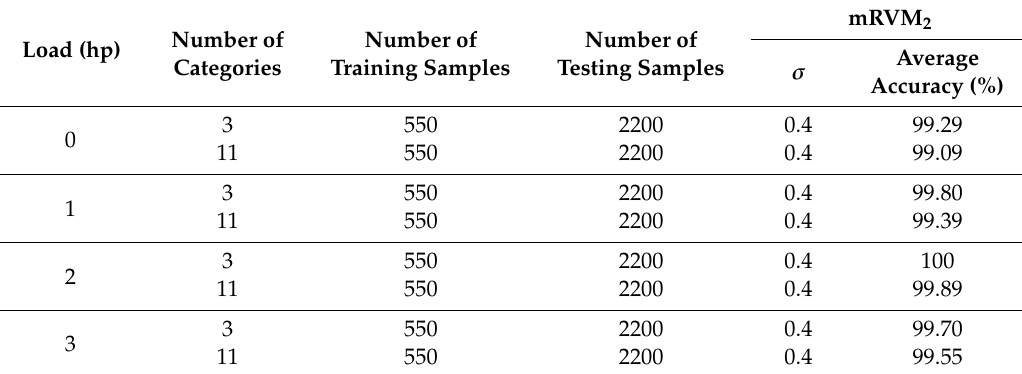
Table 8. Fault type and diameter identification under the same load.